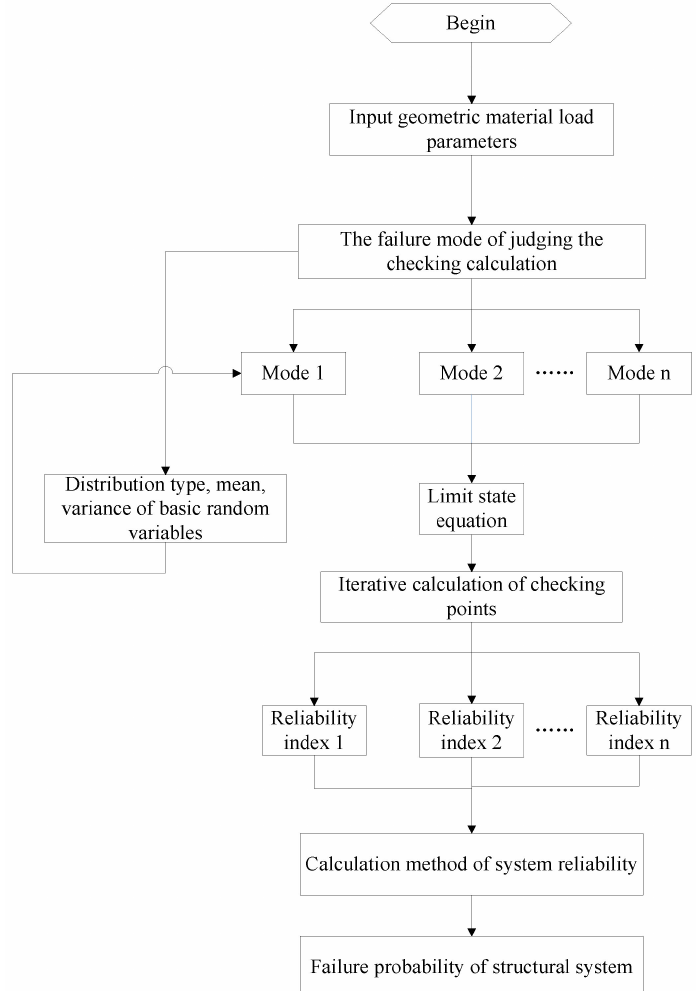
Figure 14. System reliability analysis procedure of semi-submersible